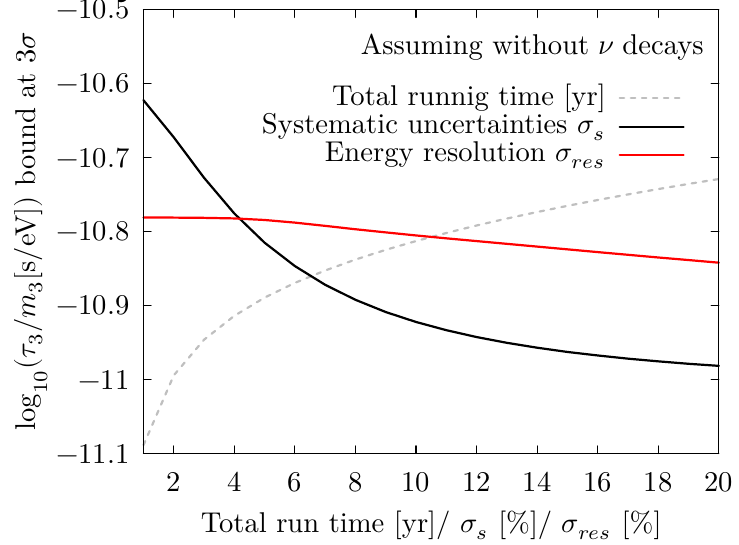
Figure 8 . The constraint at 3 (cid:27) on (cid:28) 3 =m 3 assuming the stable-neutrino case against the total running time (the short-dashed grey curve), the size of systematic uncertainty (cid:27) s (black), and the energy resolution (cid:27) res (red). We focus on the total running time from 1 to 20 years, while (cid:27) s and (cid:27) res vary in the range [1% ;